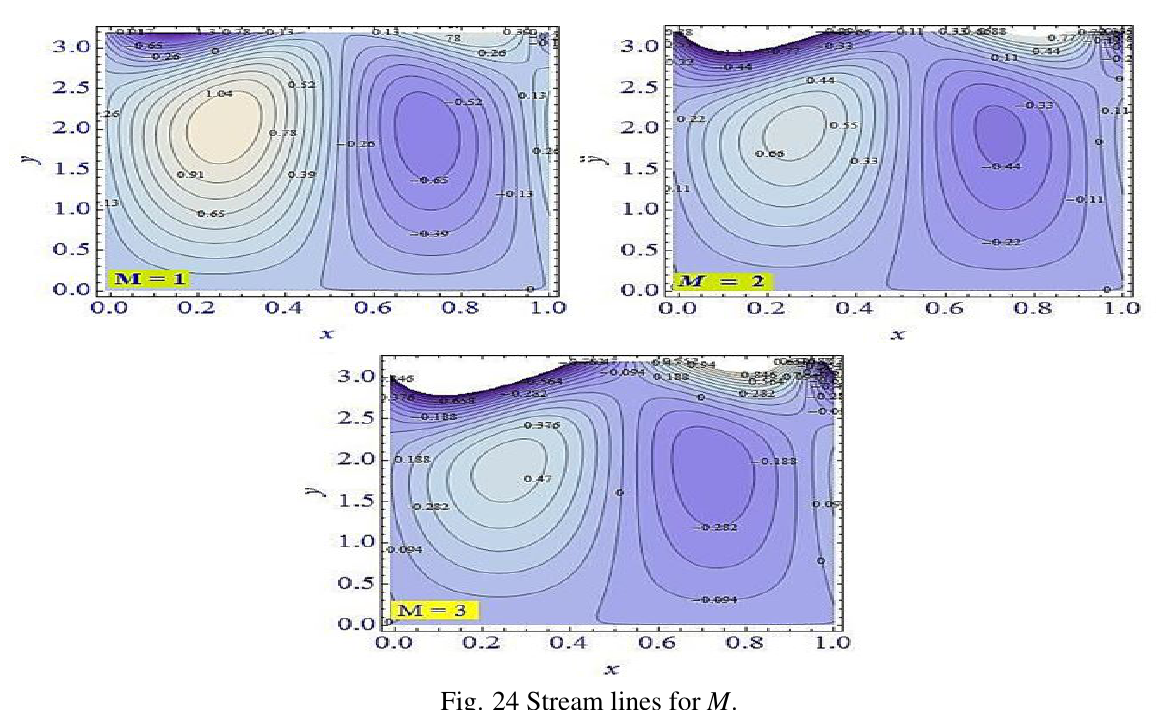
Fig. 24 Stream lines for M